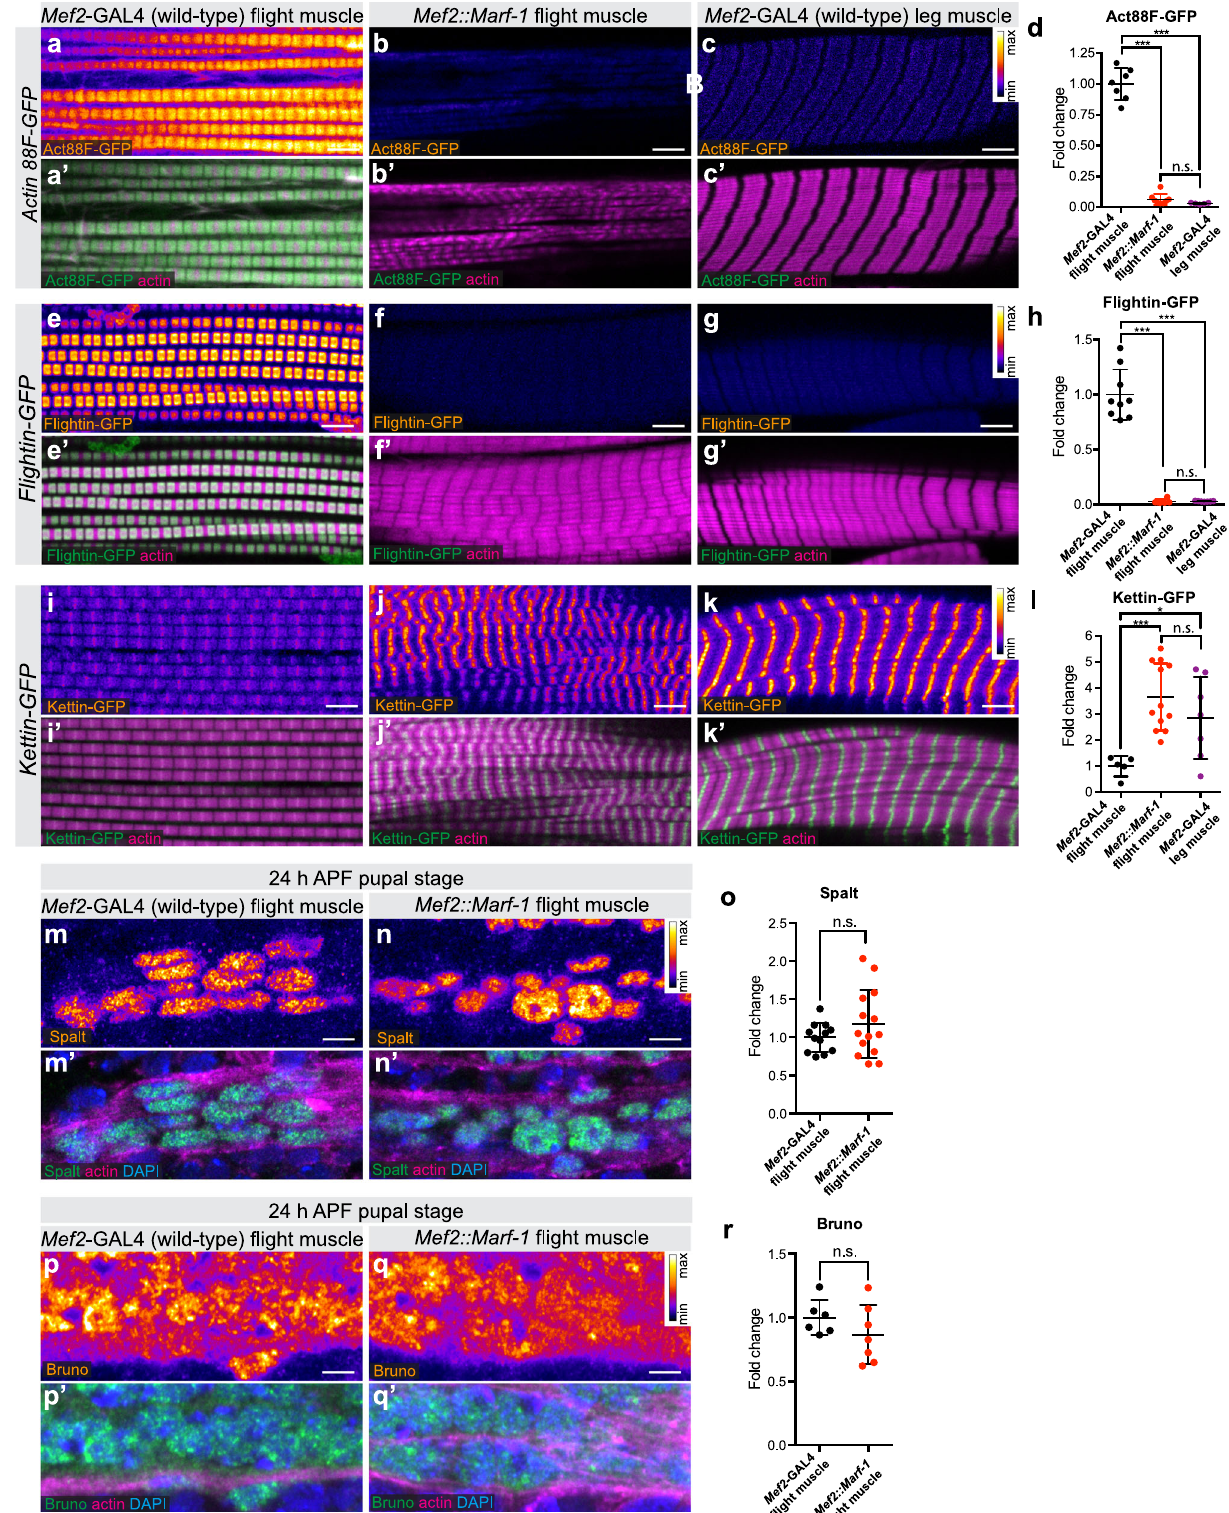
indentations caused by the myo fi brils strongly support a role for mechanical pressure from myo fi brils on mitochondria and vice versa. Third, in contrast to leg muscles, no speci fi c contact sites at particular sarcomeric locations are present in fl ight muscles arguing against localised protein-protein-interactions mediating the spatial proximity and hence favouring the mechanical